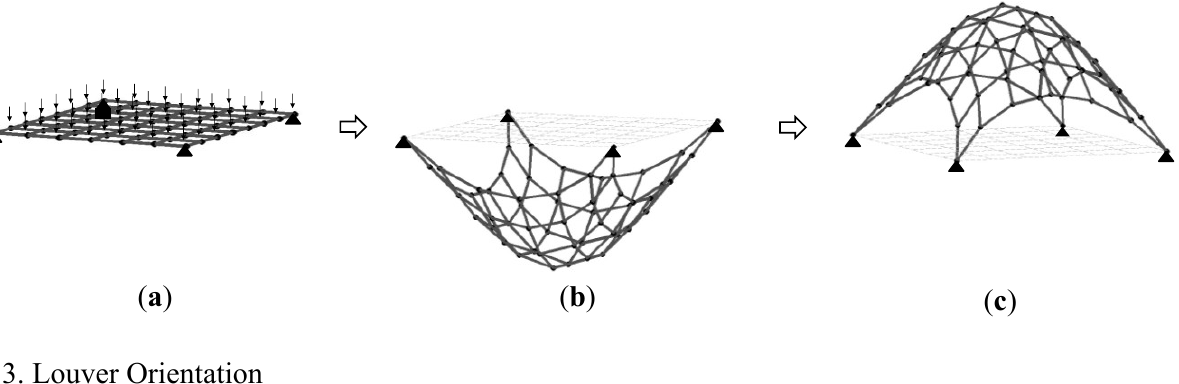
Figure 4. ( a ) Initial grid network of connected springs supported at its 4 corner extremities forms the initial geometry for the form finding process; ( b ) Upon application of loads at the spring connections, the grid relaxes into a tension only curved network; ( c ) When inverted, the form for a structurally efficient compression-only grid shell is